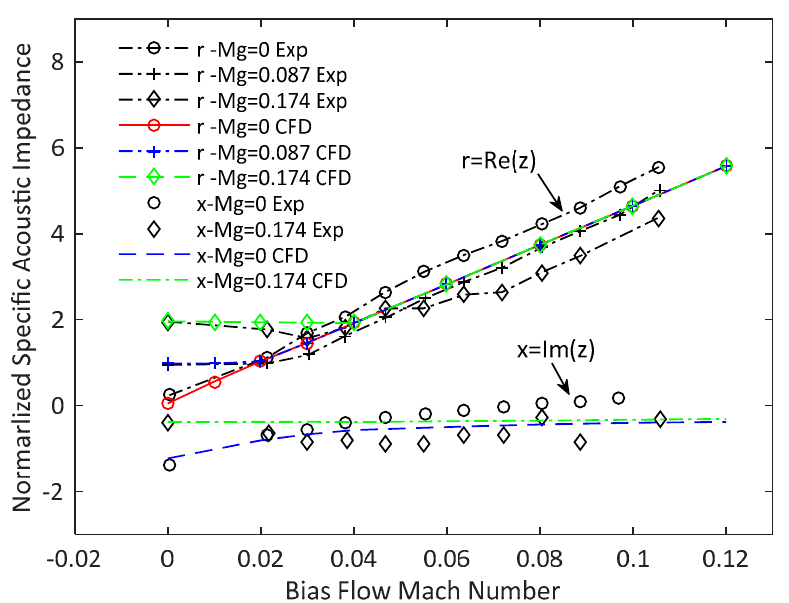
Figure 13. Numerical and experimental comparison of normalized specific acoustic impedance for liner JGB1 under various bias/grazing flow conditions [22].